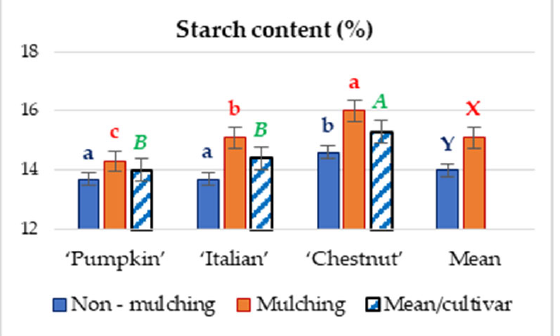
Figure 4. Starch content of tuberous sweet potato roots (%). Bars represent standard error. Means followed by same letter are not significantly different (Tukey’s multiple range test, p < 0.05). The antioxidant activity due to vitamin C content, total polyphenols, and antioxidant activity (DDPH) are shown in Figures 5–7 .